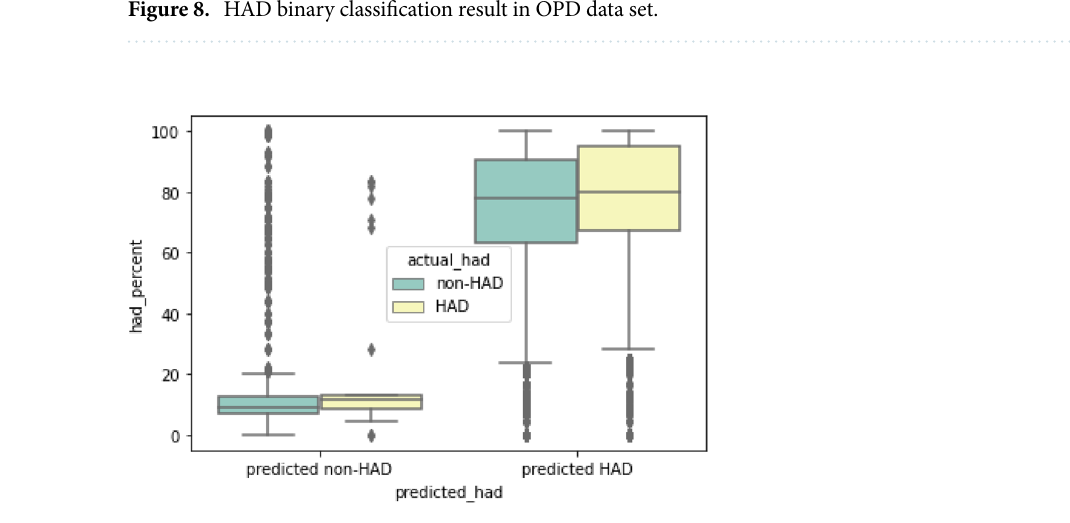
Figure 9. HAD binary classification result in IPD data set.